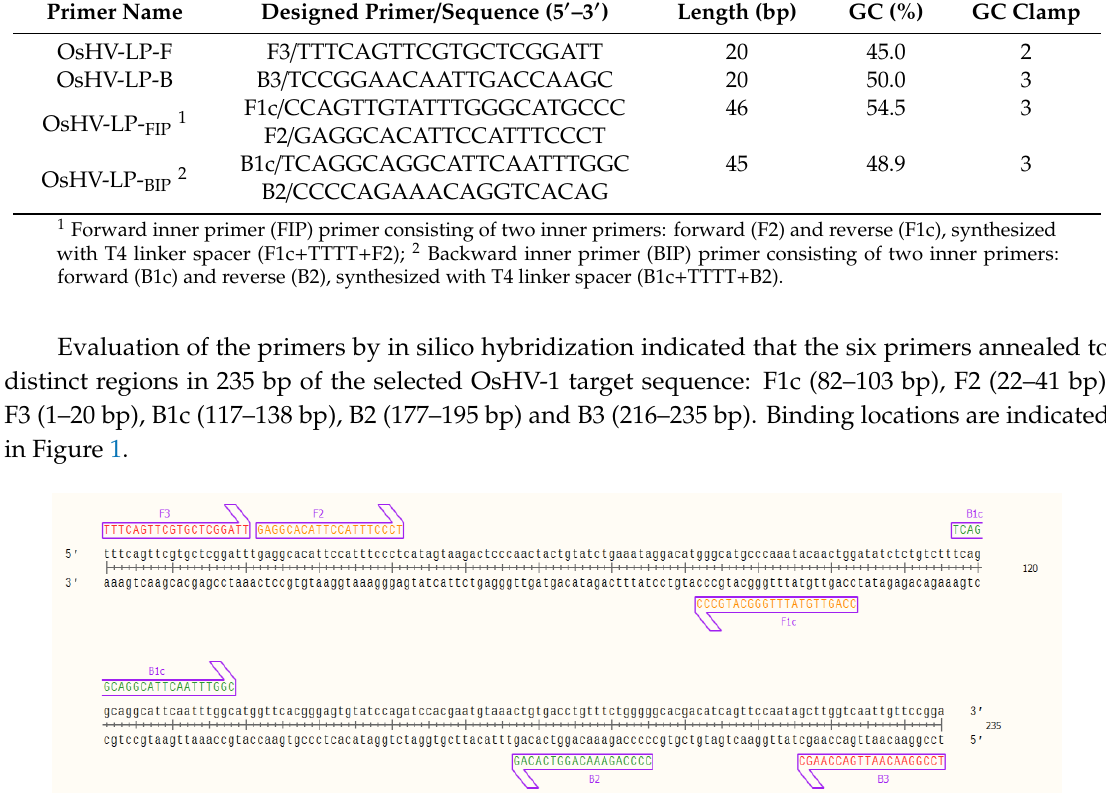
Table 1. Details of LAMP primers targeting OsHV-1 designed in this study.